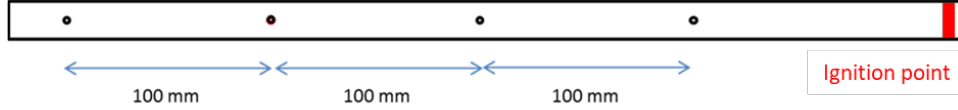
Figure 1. Scheme of the experimental gutter.